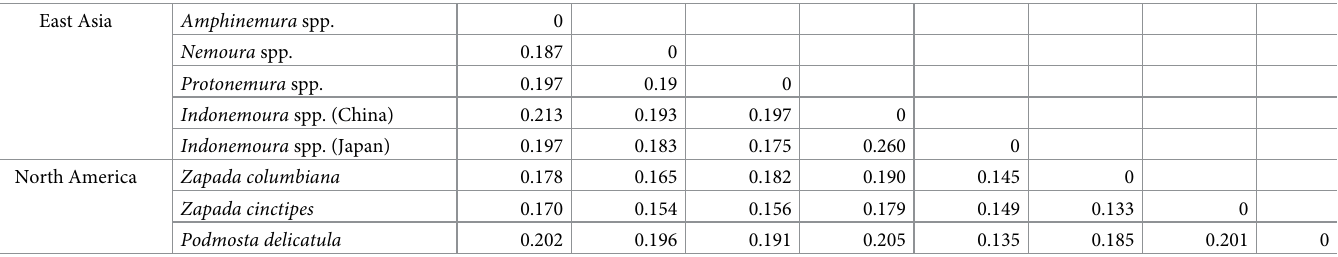
Table 2. Pairwise nucleotide substitution rate based on cox1 between the East Asian Nemouridae and North American (western USA and Alaskan) species. East Asia Amphinemura spp. 0 Nemoura